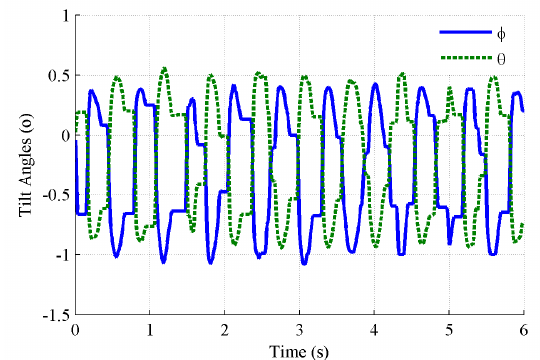
Figure 11. Tilt angles vary with time, caused by cross-coupling.